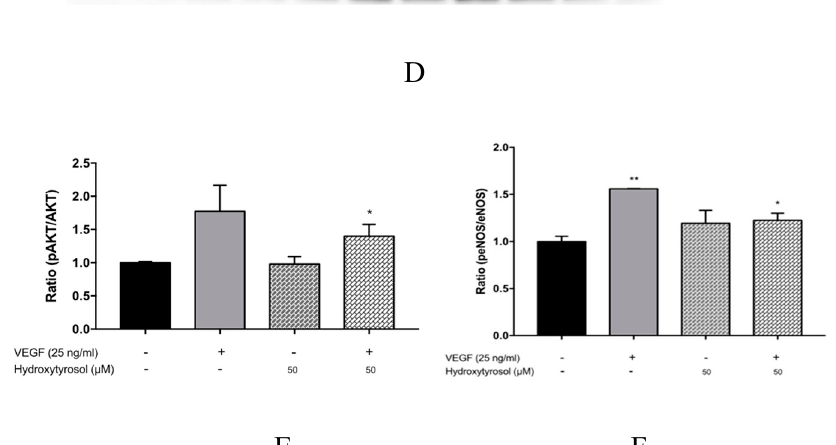
Figure 4. Melatonin and serotonin treatment significantly enhanced VEGF-induced Akt phosphorylation; hydroxytyrosol significantly increased pAkt / Akt and peNOS / eNOS ratios. HUVECs were treated with ( A ) melatonin (1 mM) and serotonin (1 mM); ( B – D ) 3-indolacetic acid (1 mM) and 5-hydroxytryptophol (1 mM); and (E and F ) hydroxytyrosol (50 µ M) for 4 h and then incubated with VEGF (25 ng / mL) for 60 min. Western blot membranes were incubated with anti-Akt and anti-p-Akt antibodies and anti-eNOS and anti-p-eNOS antibodies. Data representations of the p-Akt / Akt and peNOS / eNOS ratios are expressed as the mean ± SD ( n = 4). * p < 0.05; ** p < 0.01 versus negative control. IAA: 3-indolacetic acid; 5-HTOL: 5-hydroxytryptophol; Mel: melatonin; Ser: serotonin. Table 2. Ratio peNOS/ endothelial nitric oxide synthase (eNOS) values for melatonin and serotonin.